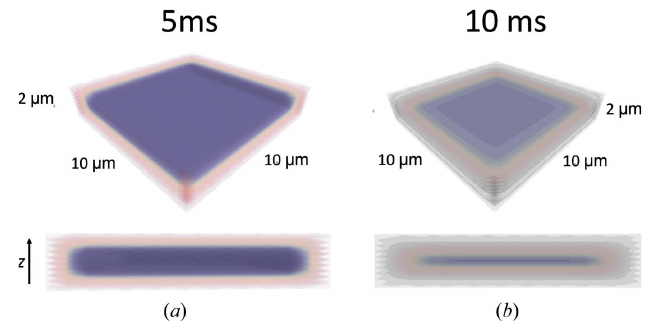
Figure 9 3D representation of CEF occupancy values in the BlaC catalytic cleft 5 ms ( a ) and 10 ms ( b ) after mixing in a typical BlaC microcrystal platelet. Dark blue colors denote low occupancies and lighter hues denote high